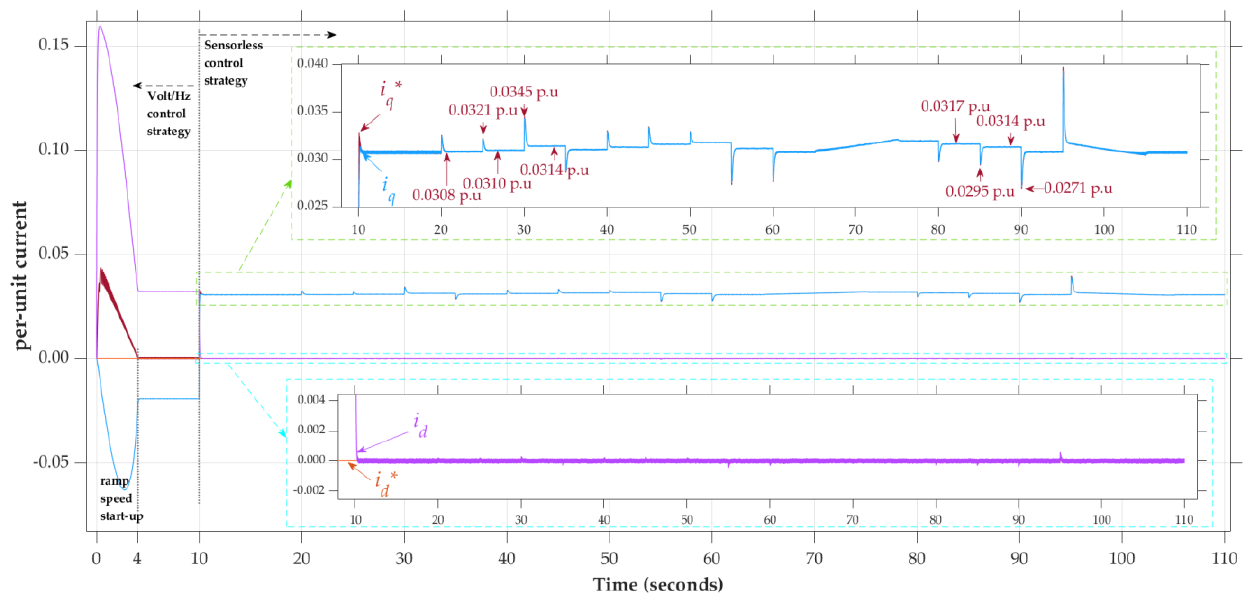
Figure 13. Simulation results for current responses in the d-q axis.